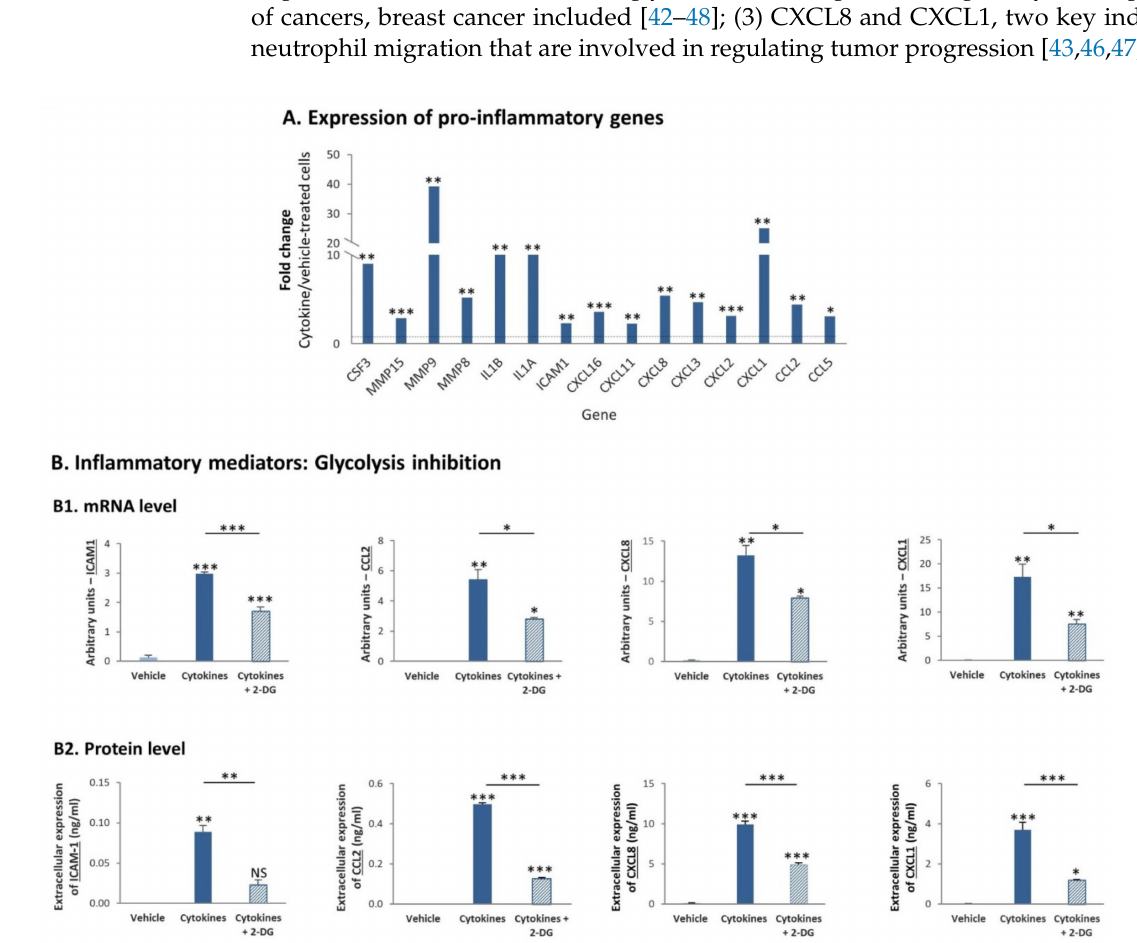
Figure 10. Continuous TNF α + IL-1 β stimulation upregulates the mRNA and protein expression levels of proinflammatory mediators in TNBC cells, in a glycolysis-dependent process ( A ). MDA-MB-231 cells were continuously stimulated by TNF α + IL-1 β , or treated by vehicle control (as described in Figure 1). Fold change in expression of proinflammatory genes between cytokine-stimulated and vehicle-treated cells was determined by the transcriptome analyses described in Figure 2. *** p < 0.001, ** p < 0.01, * p < 0.05. ( B ) mRNA levels and protein levels of proinflammatory mediators. ( B1 ) mRNA levels were determined by quantitative RT-PCR. The results of a representative experiment of n = 3 are presented. *** p < 0.001, ** p < 0.01, * p < 0.05. ( B2 ) Protein levels were determined by ELISA and are presented relative to cell numbers. The results of a representative experiment of n = 3 are presented. *** p < 0.001, ** p < 0.01, * p < 0.05. NS, Not